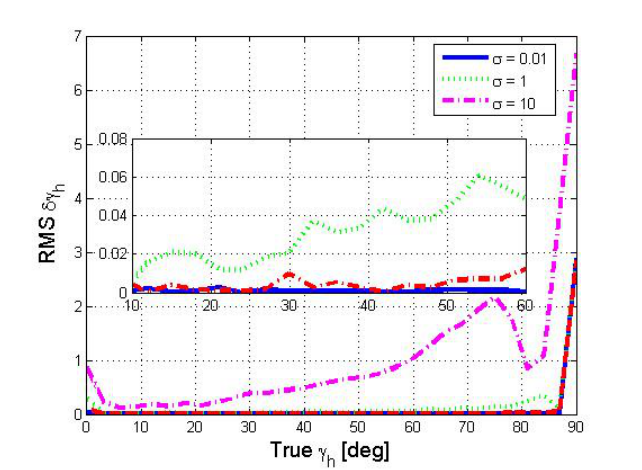
Figure 8. RMS of δγ h as a function of γ h . Use of 150 acceleration measurements. Curves represent different accelerometer variance values σ in units of µ g/